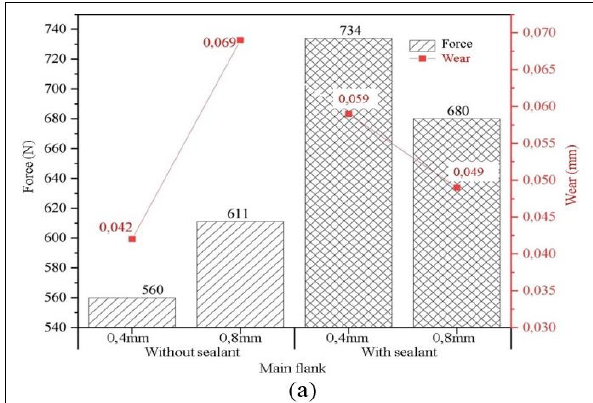
Figure 10a: Machining forces x wear: (a) Main flank.